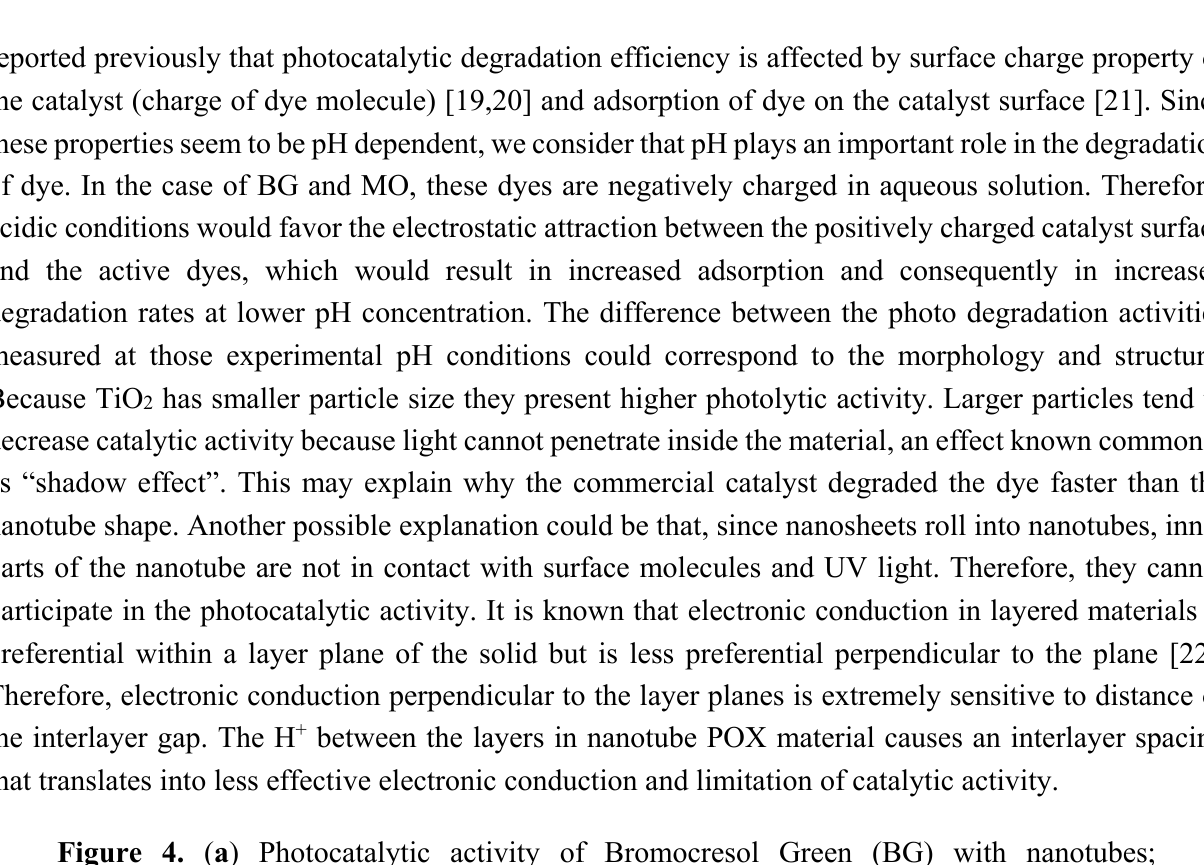
Figure 4. ( a ) Photocatalytic activity of Bromocresol Green (BG) with nanotubes; ( b ) Photocatalytic activity of Methyl Orange (MO) with nanotubes; ( c ) Photocatalytic activity of BG with TiO 2 ; ( d ) Photocatalytic activity of MO with TiO 2